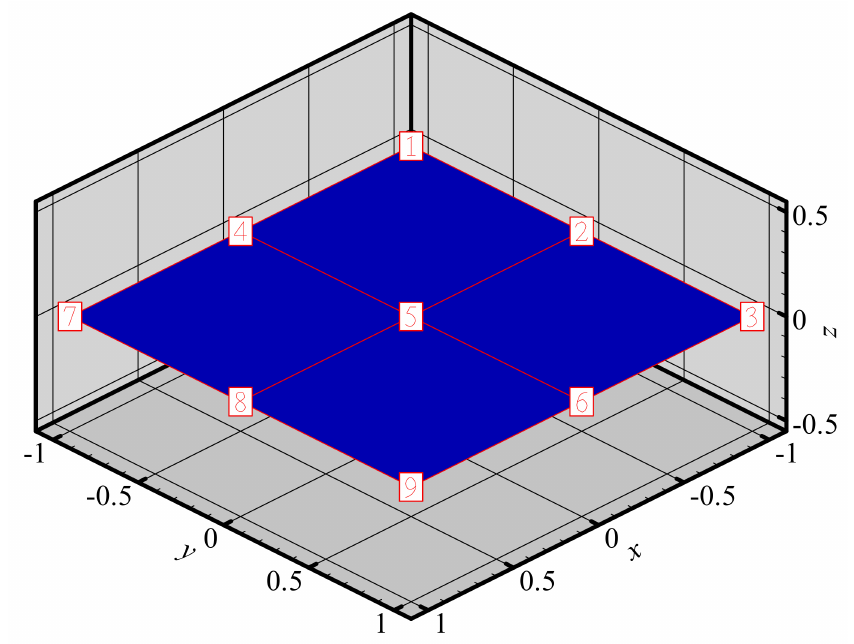
Figure 3. A two − dimensional domain (2 m × 2 m) discretized with 4 quadrilateral elements and 9 nodes.